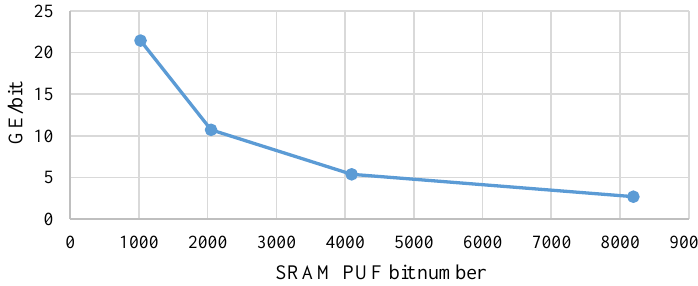
Figure 20. Relationship between PUF bit number and GE per bit in this design.